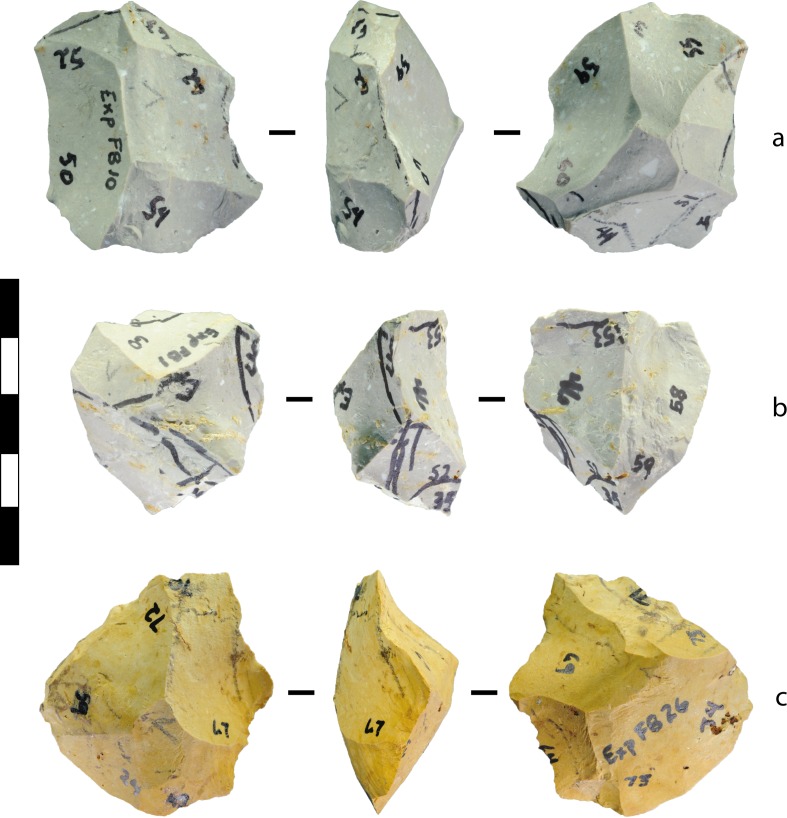
Experimental bifacial cores produced from flake blanks and displaying approximate radial symmetry.The numbers written on the cores denote potential (but unselected) platforms. (A) Silcrete, experiment 10, after 19 blows. (B) Silcrete, experiment 1, after 22 blows. (C) Silcrete, experiment 26, after 23 blows. Scale 50 mm.